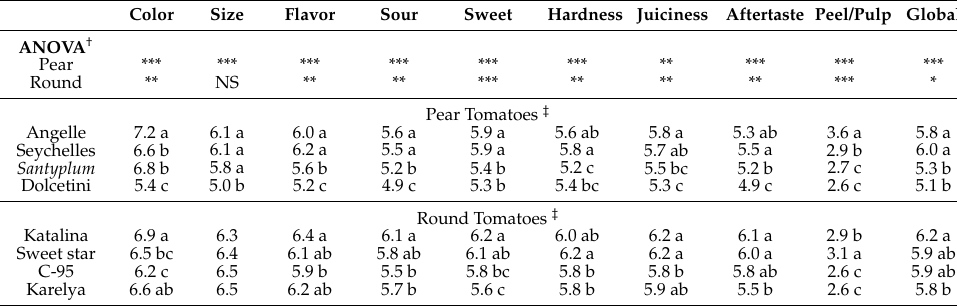
Table 6. Consumer study in cherry tomatoes as affected by